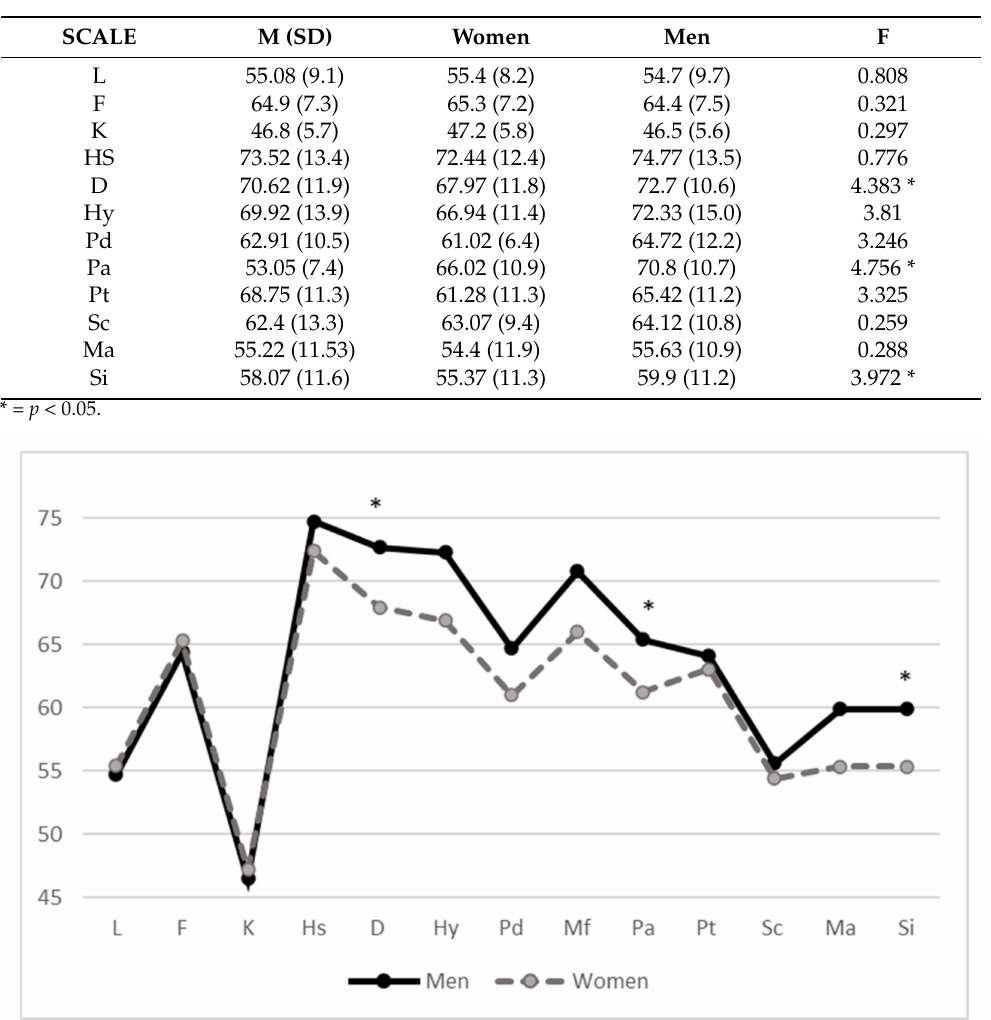
Table 2. Descriptive statistics of Minnesota Multiphasic Personality Inventory—2 (MMPI-2) clinical scales and gender differences.